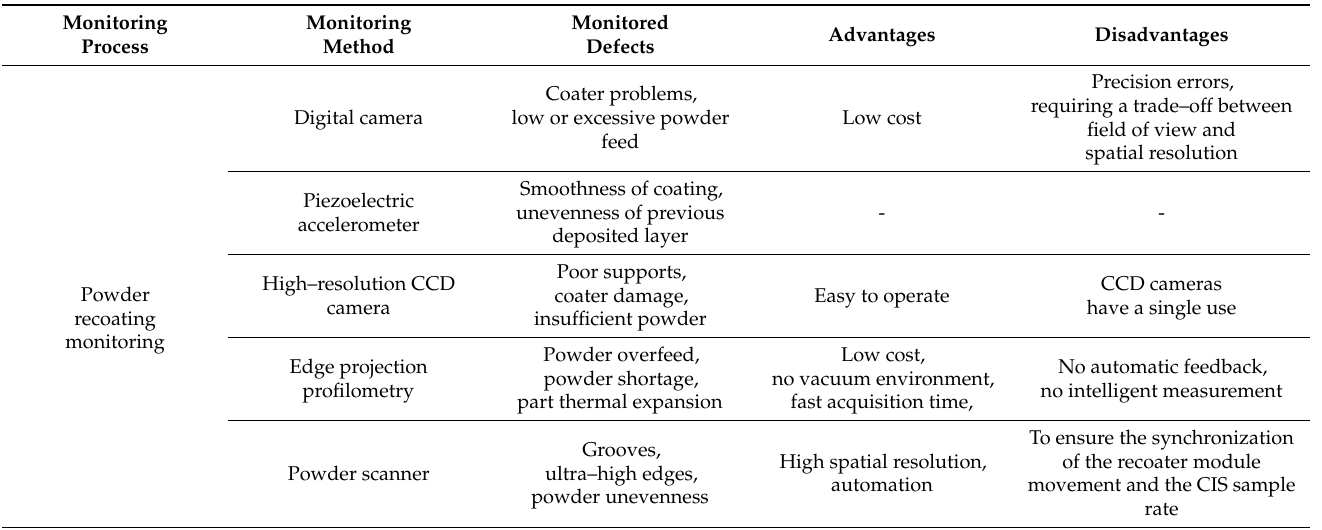
Table 1. Summarizes the powder recoating monitoring process.